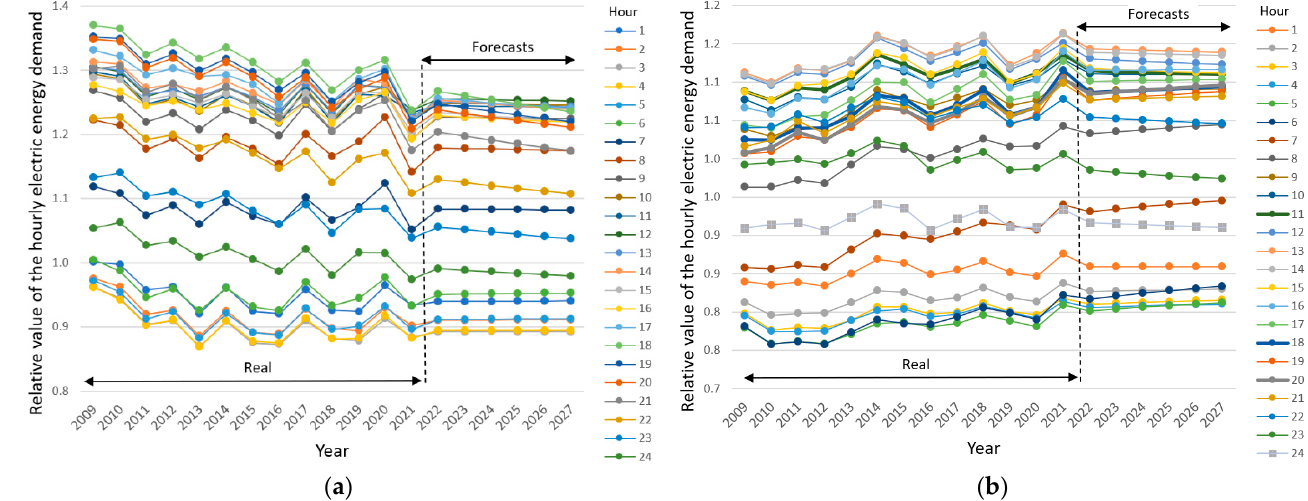
Figure 14. ( a ) Forecast relative power demand in particular hours of the winter typical day; ( b ) Forecast relative power demand in particular hours of the summer typical day.